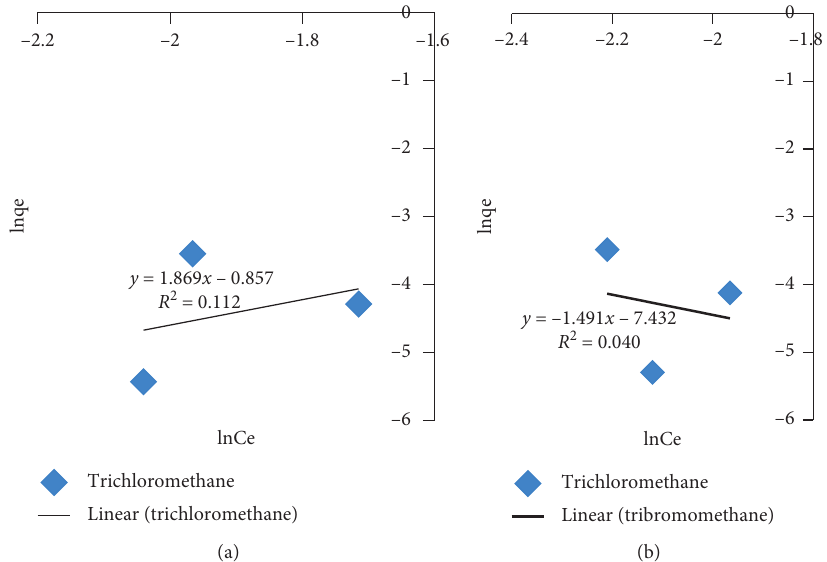
Figure 8: Freundlich adsorption isotherms for the adsorption of (a) trichloromethane and (b) tribromomethane using Moringa oleifera seed husk activated